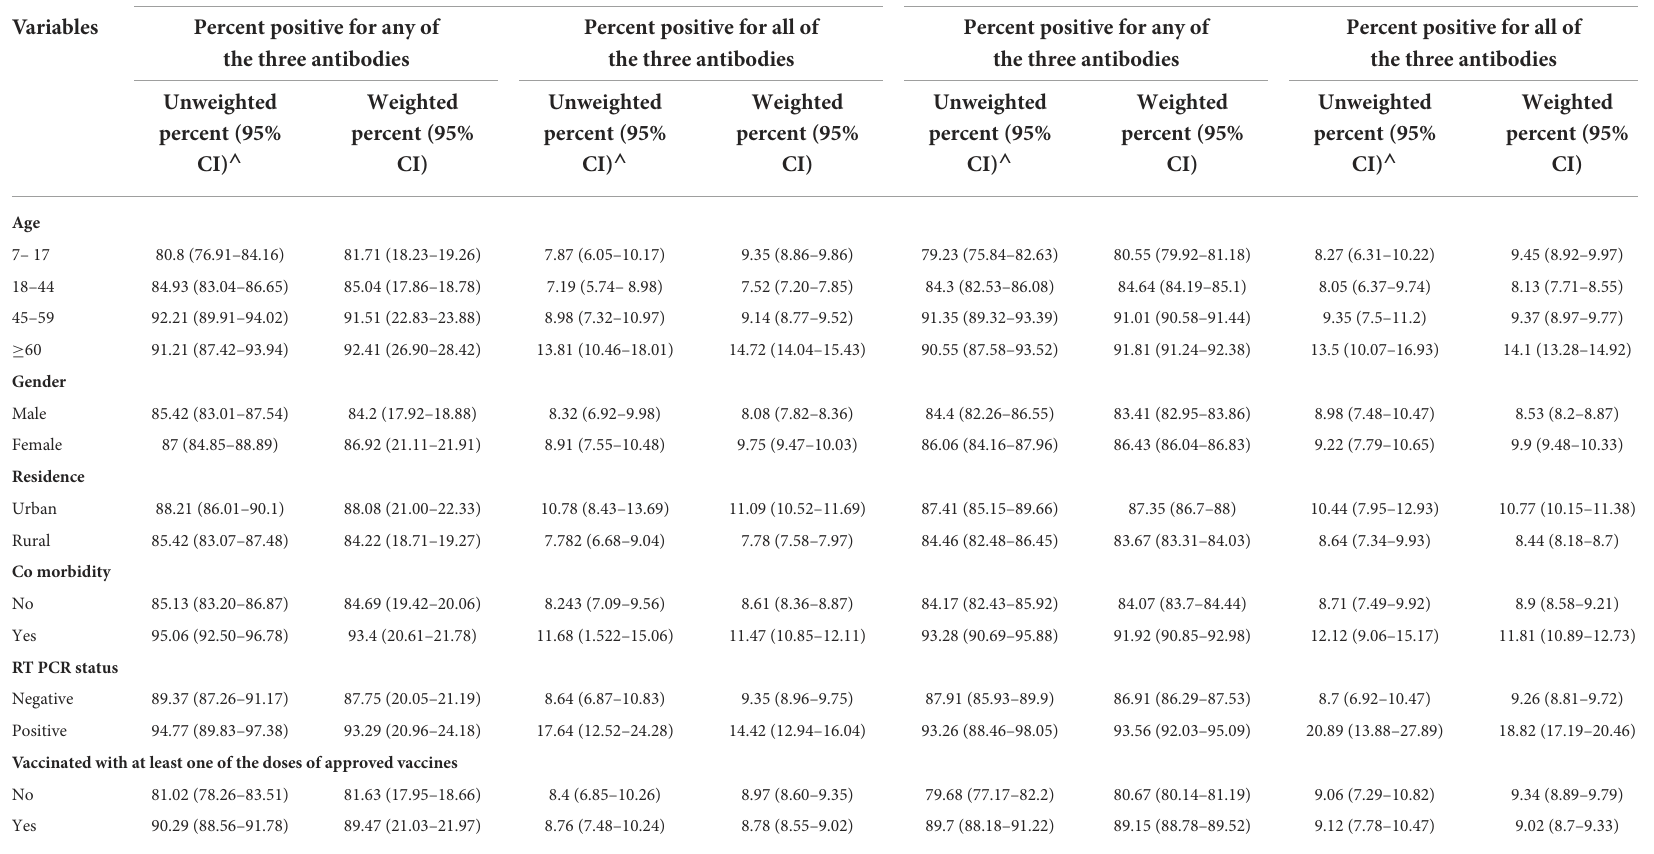
TABLE 4 Seropositivity for any one of the antibodies (Anti-Nucleocapsid IgG/Anti-spike IgG/IgM Antibodies) and all the three antibody types simultaneously. Analysis of the Complete case data, N =